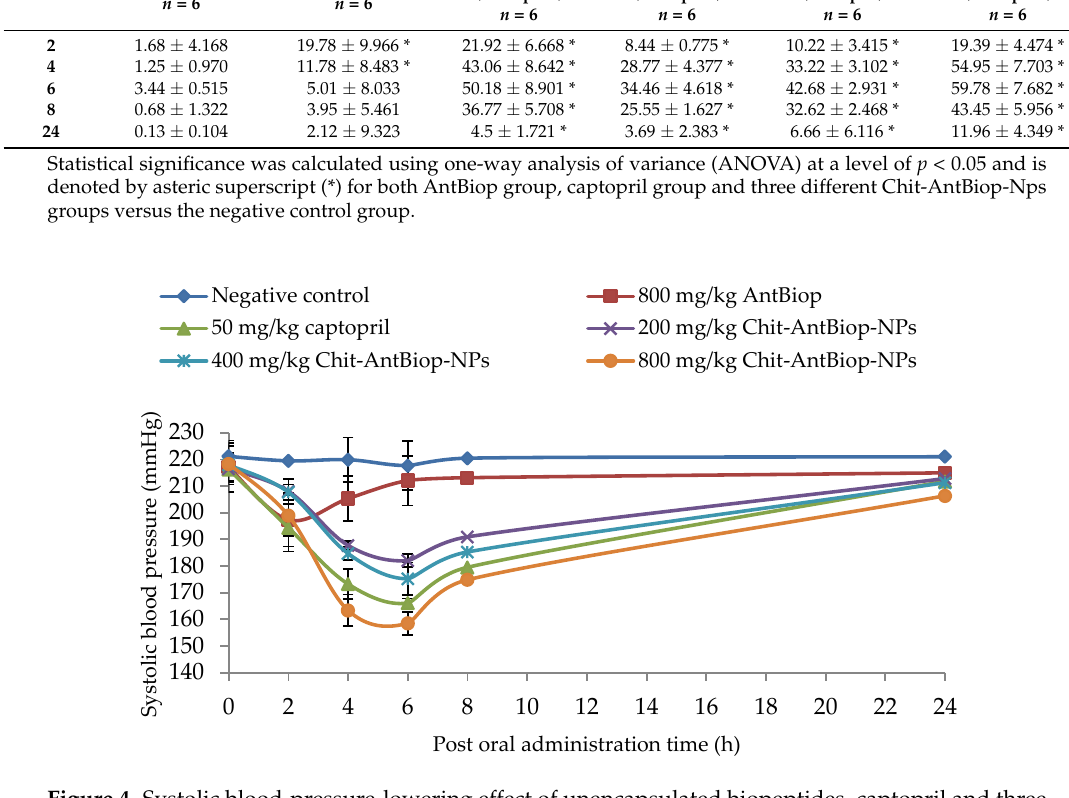
Figure 4. Systolic blood-pressure-lowering effect of unencapsulated biopeptides, captopril and three doses of Chitosan-AntBiop-NPs within 24 h of single oral administration on SHRs.